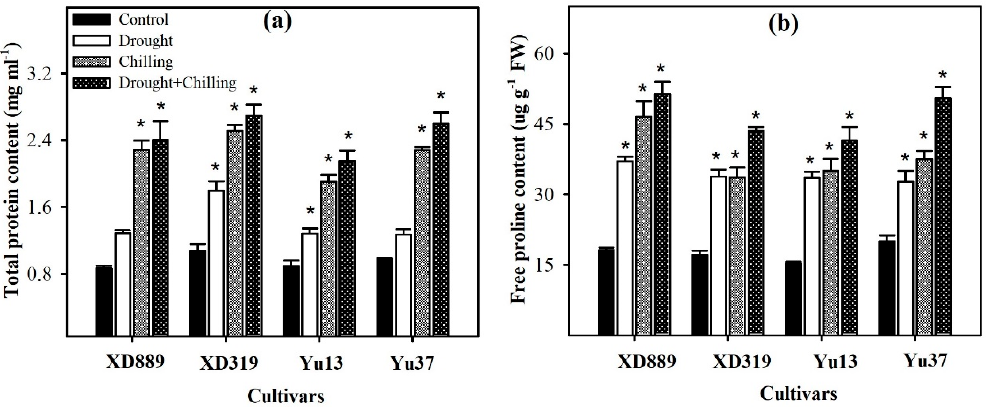
Figure 12. Accumulation of total soluble proteins ( a ) and free proline contents ( b ) in the leaves of four maize cultivars as influenced by the drought, chilling, and drought + chilling stresses. Vertical bars above mean indicate standard error of three replicates. Mean value for each treatment with * indicate significant differences compared with control according to LSD test ( P ≤ 0.05).